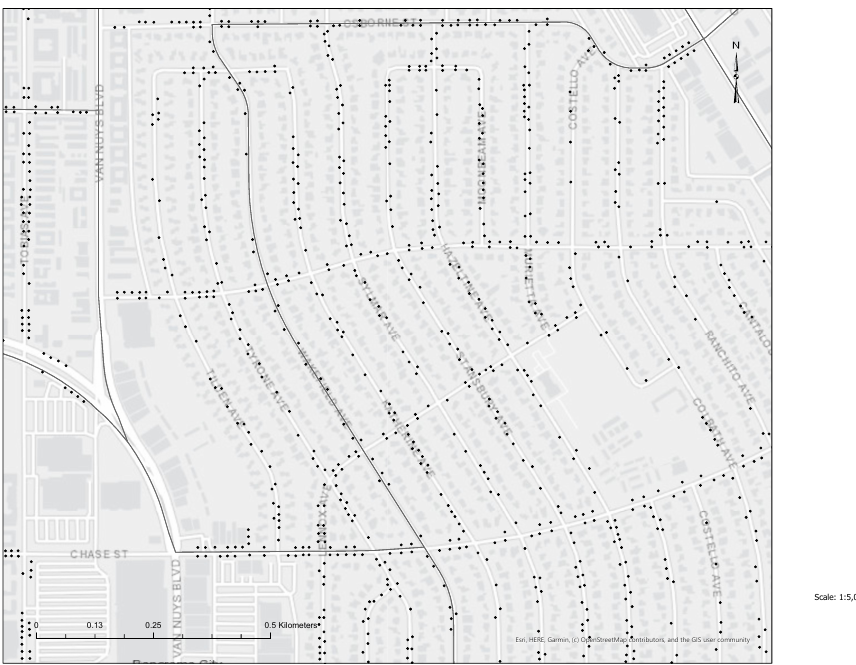
Figure 10. Panorama City secondary streets with PMTs, showing the opportunity to increase green cover in the San Fernando Valley.